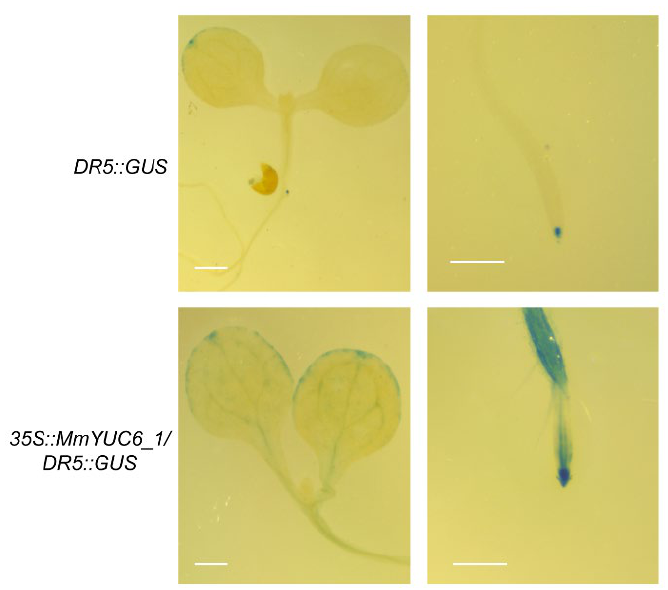
Figure 5. GUS staining of DR5::GUS and 35S::MmYUC6_1/DR5::GUS transgenic plants. Bar scale, 1 mm.